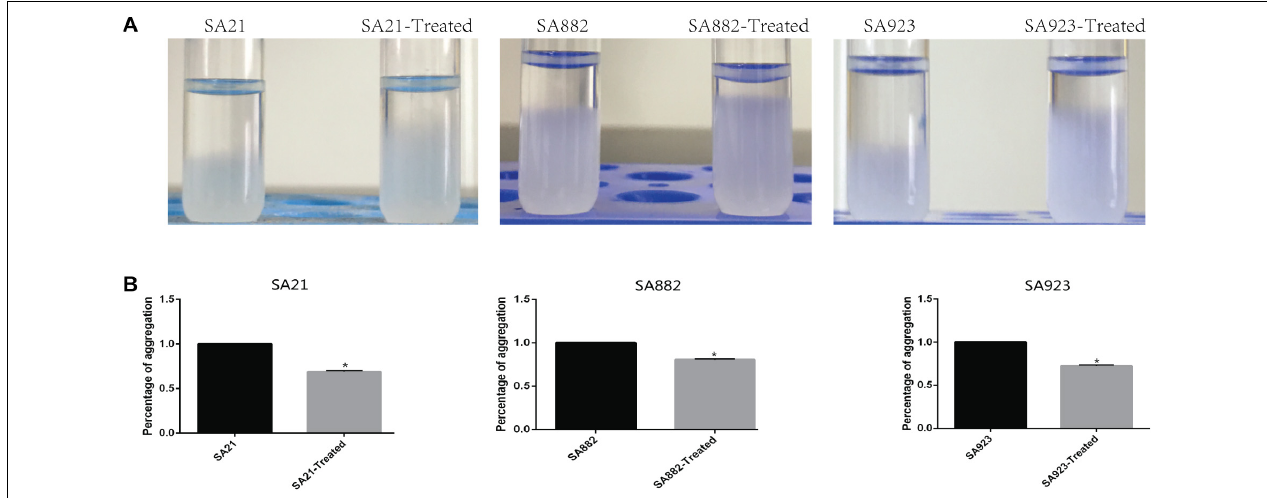
FIGURE 5 | Effect of ZY-214-4 on S. aureus cell aggregation. (A) Micrographs of S. aureus autoaggregation upon ZY-214-4 treatment. (B) Quantitative analysis of S. aureus aggregation. ZY-214-4 inhibited aggregation relative to untreated control cells. * P < 0.05.